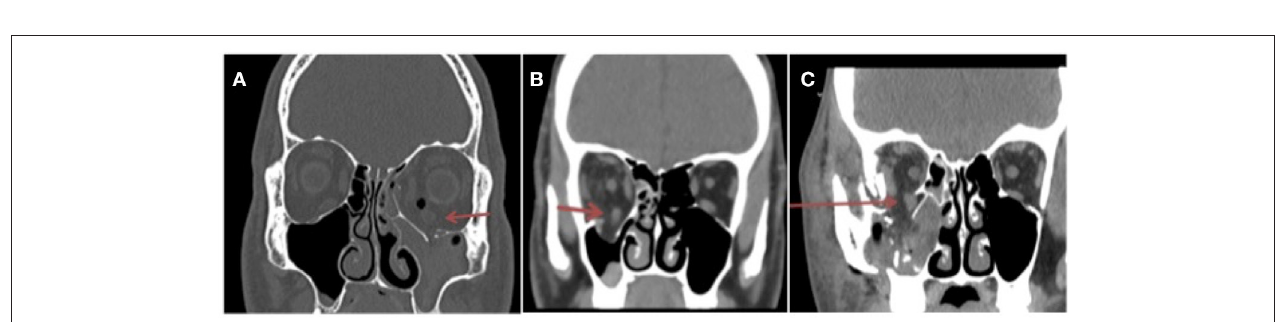
FIGURE 3 | Coronal slice of facial bones CT demonstrating left orbital floor and medial wall fractures. Inferior rectus muscle is positioned (A) above the fracture plane (red arrow). The left maxillary sinus is obliterated and filled with blood. (B) The inferior rectus muscle is lying through the imaginary fracture plane. (C) The inferior rectus muscle falls below the fracture plane (red arrow) into the maxillary